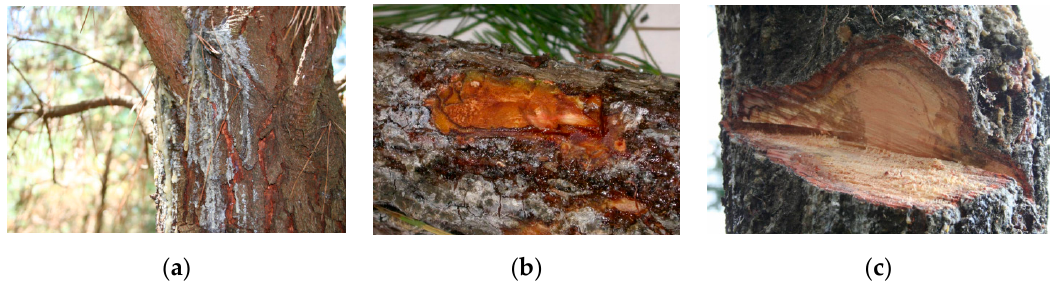
Figure 1. Sampling of cankers caused by F. circinatum ( a ) A canker on Monterey pine ( Pinus radiata ) in the forest ( b ) collecting wood pieces for culture isolation ( c ) Gap after wood sampling using a chainsaw. Dark discolouration indicates the progression areas of F. circinatum .